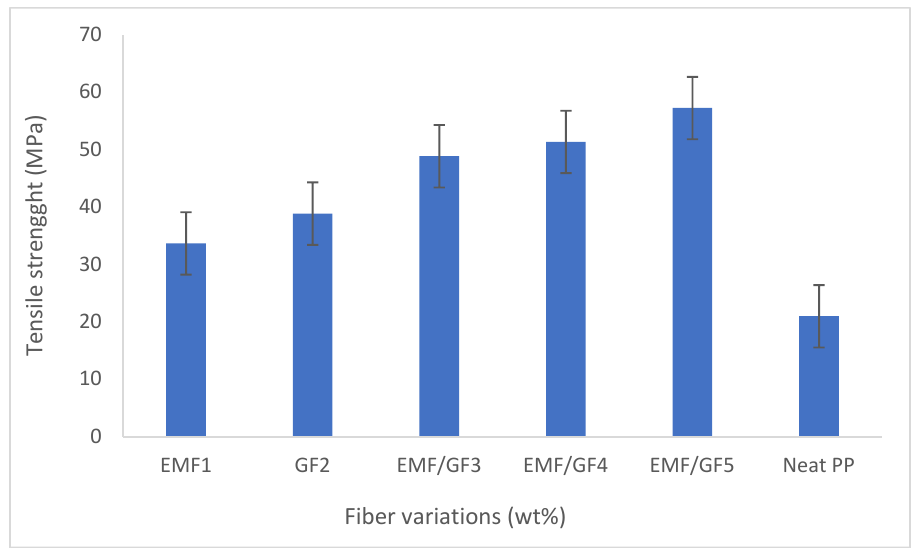
Figure 5. Comparison of tensile strength of the reinforced and unreinforced composites.